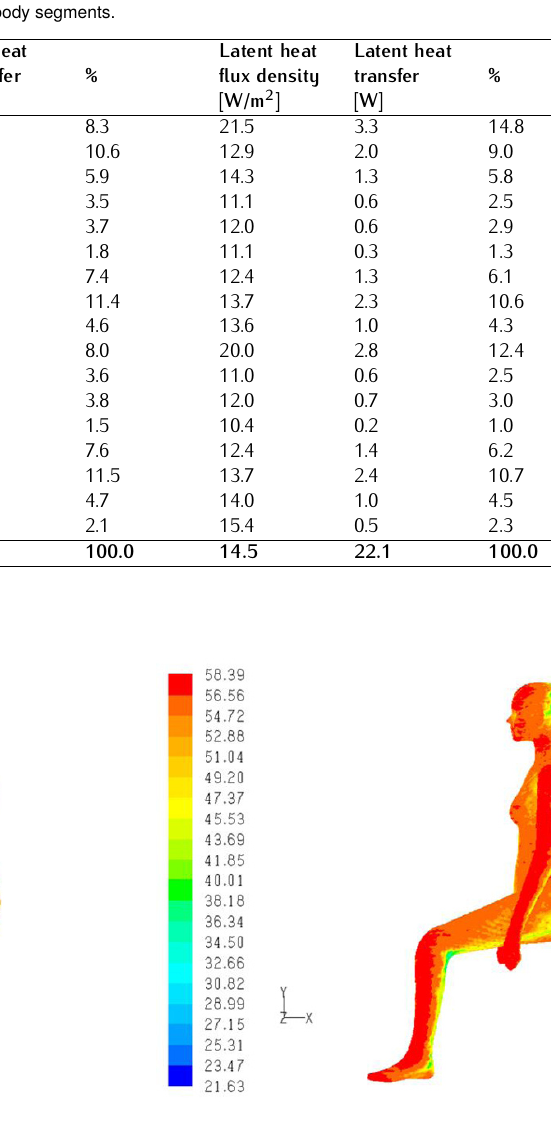
is shown on Figure 12. Low wettedness indicates regions with small latent heat loss and correlates well with the sensation of comfort. Skin wettedness cannot be less than 0.06 due to the natural uncontrollable diffusion of water through the skin dermal layer, and cannot exceed 1.0 which corresponds to completely wet body. Completely wet body does not ensure that all excess heat will be released, but that this heat will be the maximum available under the room conditions. This maximum depends on the